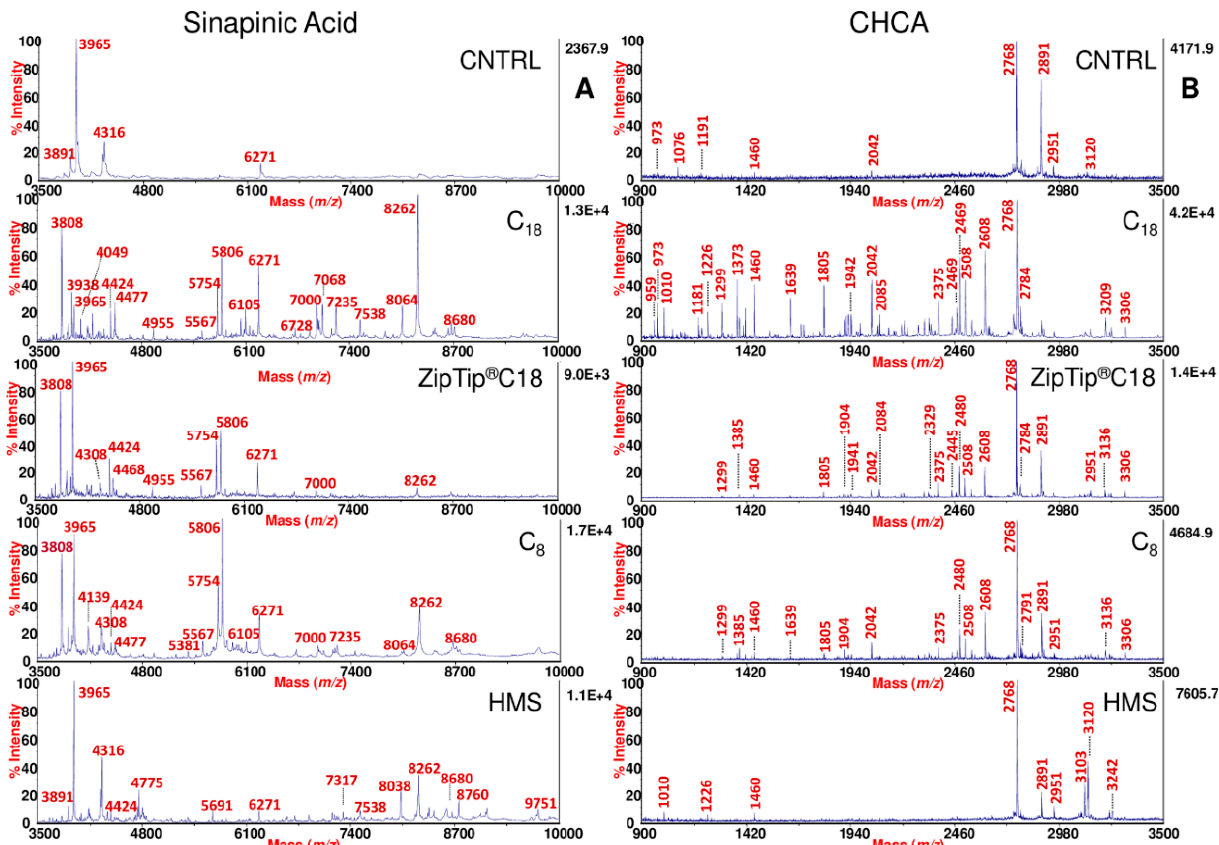
Figure 2. MALDI-TOF MS zoom view of SP using SA and CHCA matrices. MALDI-TOF mass spectra of SP obtained from one fertile normozoospermic subject using SA ( A ) and CHCA ( B ), before and after processing by C 18 , ZipTip ® C18, C 8 , and HMS. For SA, the spectra are shown in the m / z range from 3500 to 10,000. For CHCA, the spectra are shown in the m / z range from 900 to 3500, with labeled monoisotopic peaks.